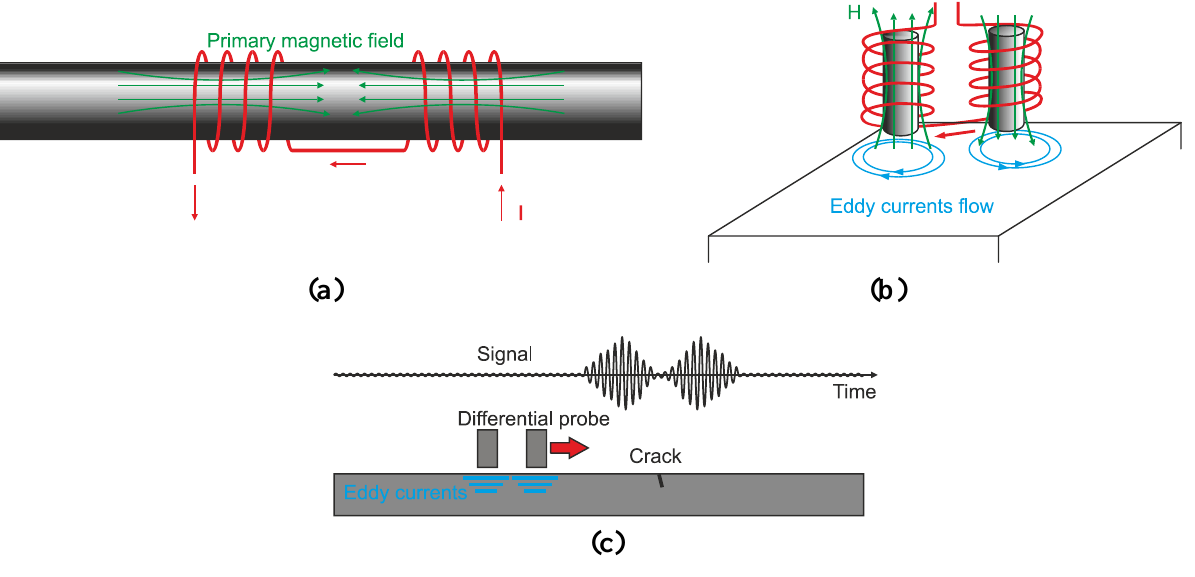
Figure 23. (a) Differential double-function encircling coil. (b) Differential double-function pancake-type coil. (c) Signal from differential coil